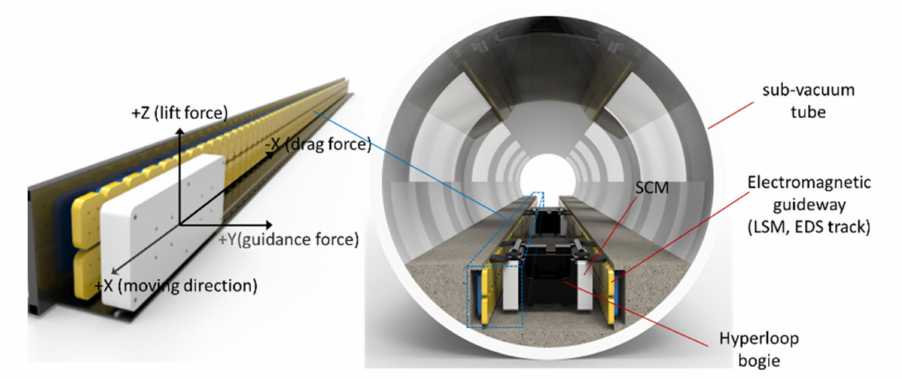
Figure 2. Concept of the Hyperloop bogie driving in the sub-vacuum tube with an